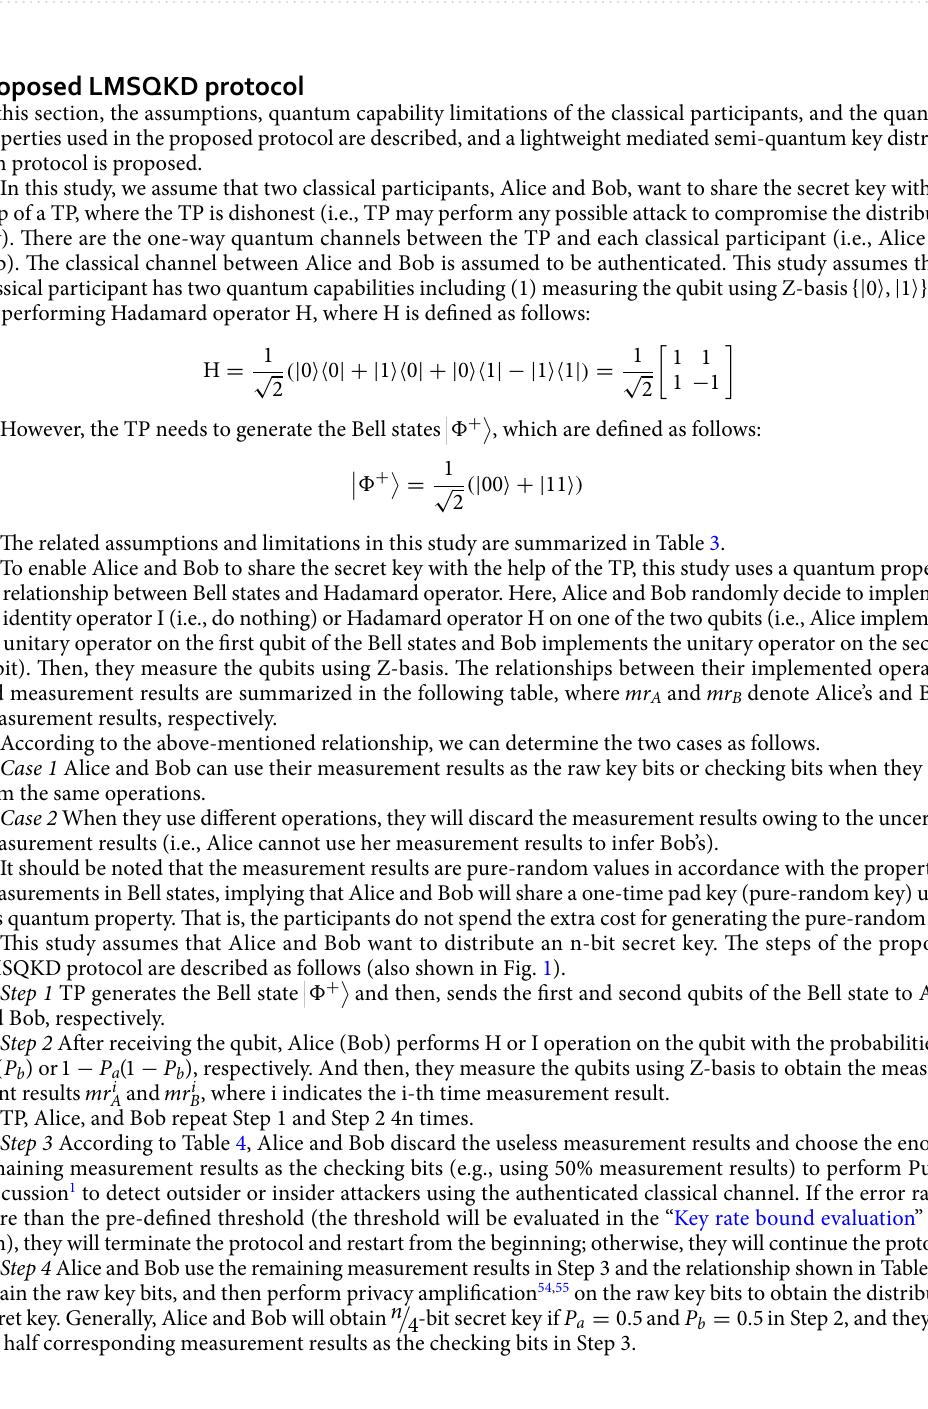
Table 3. Summary of assumptions and